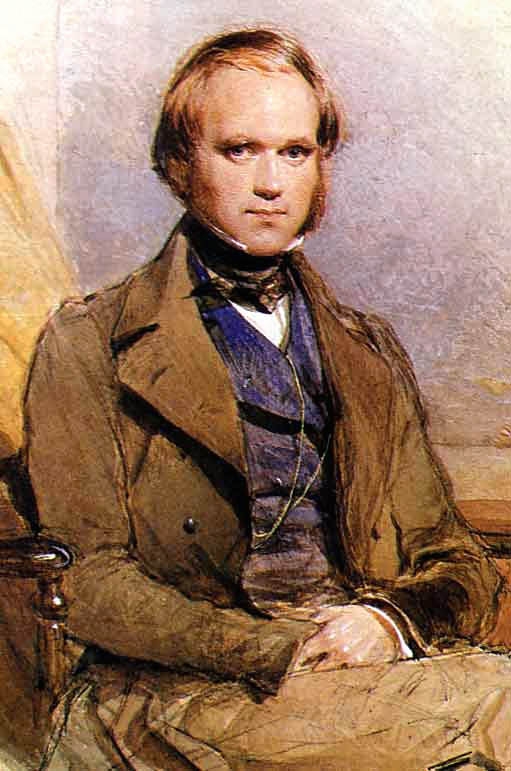
Language and DarwinThe idea that modern languages had descended from a common ancestor, as proposed by Sir John Herschel, inspired the young Charles Darwin to think about the notion of descent with modification in relation to biological evolution. (Water-color portrait of Charles Darwin painted by George Richmond in the late 1830s.)